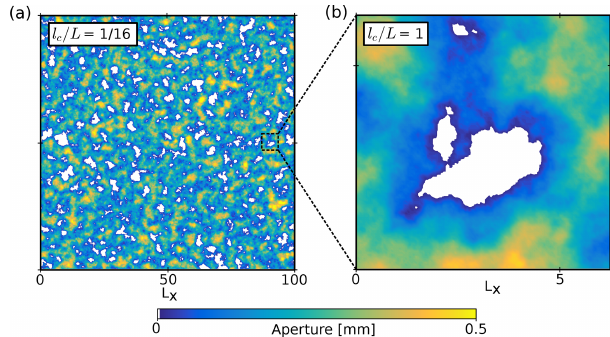
Figure 1. (a) Aperture field of a synthetically generated frac- ture ( d = 1mm, σ s = 0 . 5mm, H = 0 . 9) with a l c /L ratio of 1 / 16. (b) Zoomed-in image showing the uncorrelated part of the aperture field. Units of L x are in millimeters.